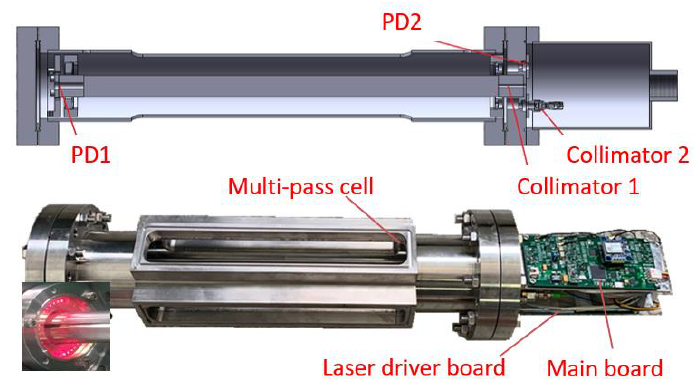
Figure 1. The assembled compact open-path atmospheric CO 2 and H 2 O sensor based